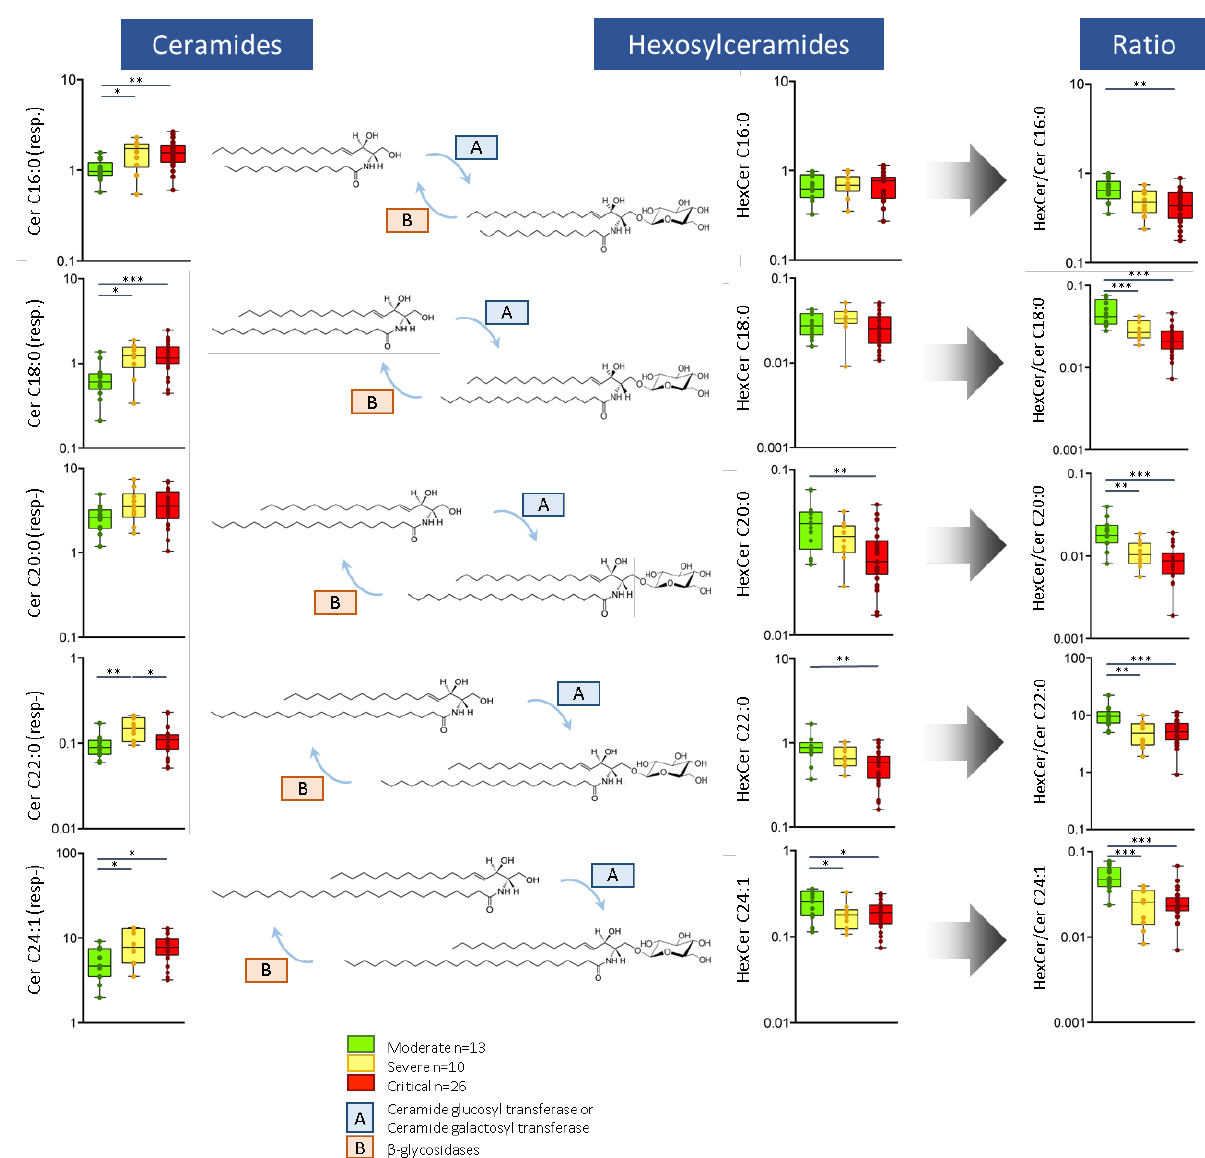
Figure 2. Plasma metabolic levels of long-chain ceramides (in response), hexosylceramides (in response), and hexosylceramide/ceramide ratios in hospitalized patients with COVID-19. Abbreviations: Cer: ceramides; HexCer: hexosylceramides, resp.: response. * p ≤ 0.05, ** p ≤ 0.01, *** p ≤ 0.001.